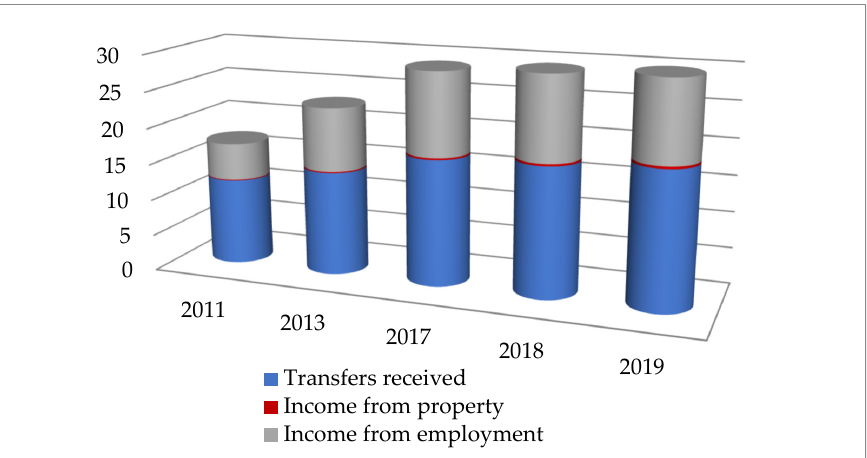
Figure 1. Dynamics of the level and structure of income of retired households in Russia (on average per household member per month, thousand rubles).